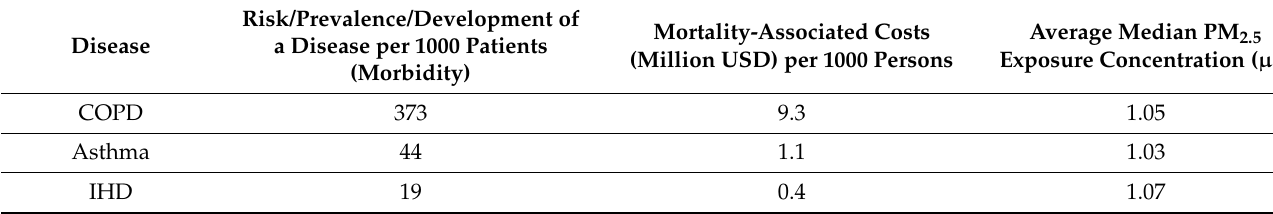
Table 2. Burden of PM 2.5 per 1000 persons for each health effect endpoint.